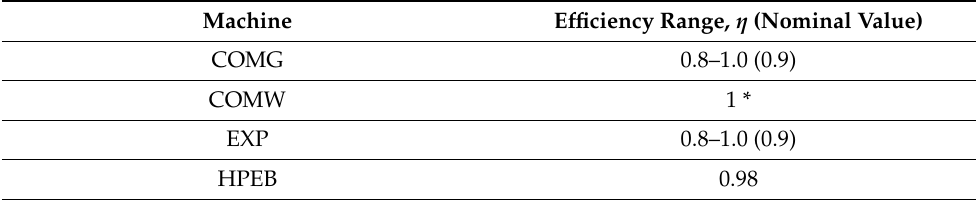
Table 4. Efficiencies of the system machinery used. Based on values in